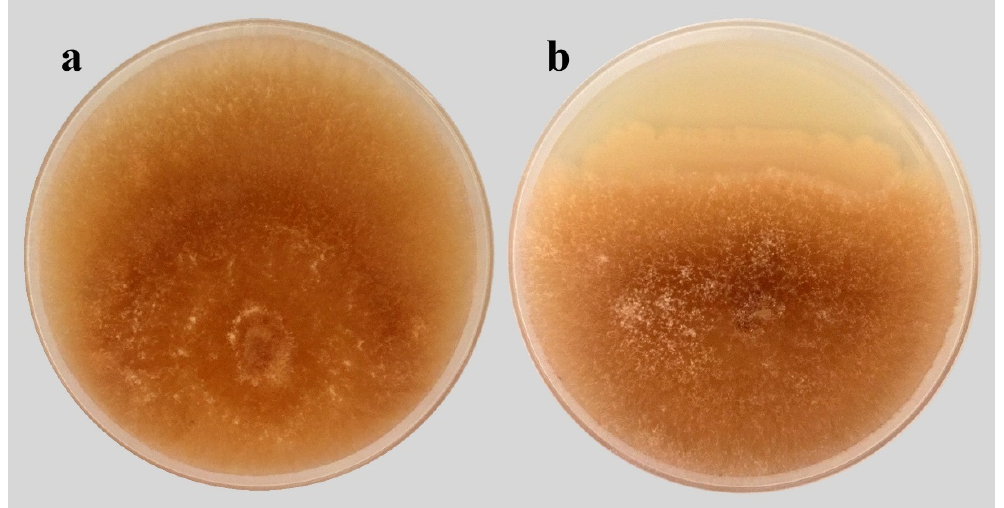
Figure 2. A dual culture test revealing the antifungal activity of Bacillus subtilis SR22 against Rhizoctonia solani , where ( a ) control plate, and ( b ) dual culture plate.